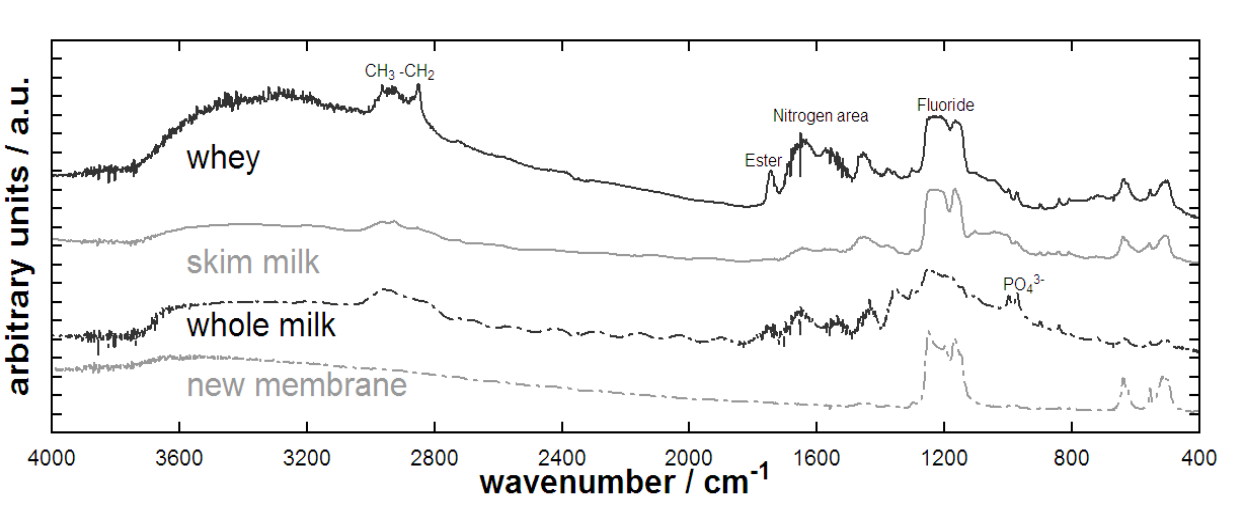
Figure 8. FTIR of fouled membranes and a new